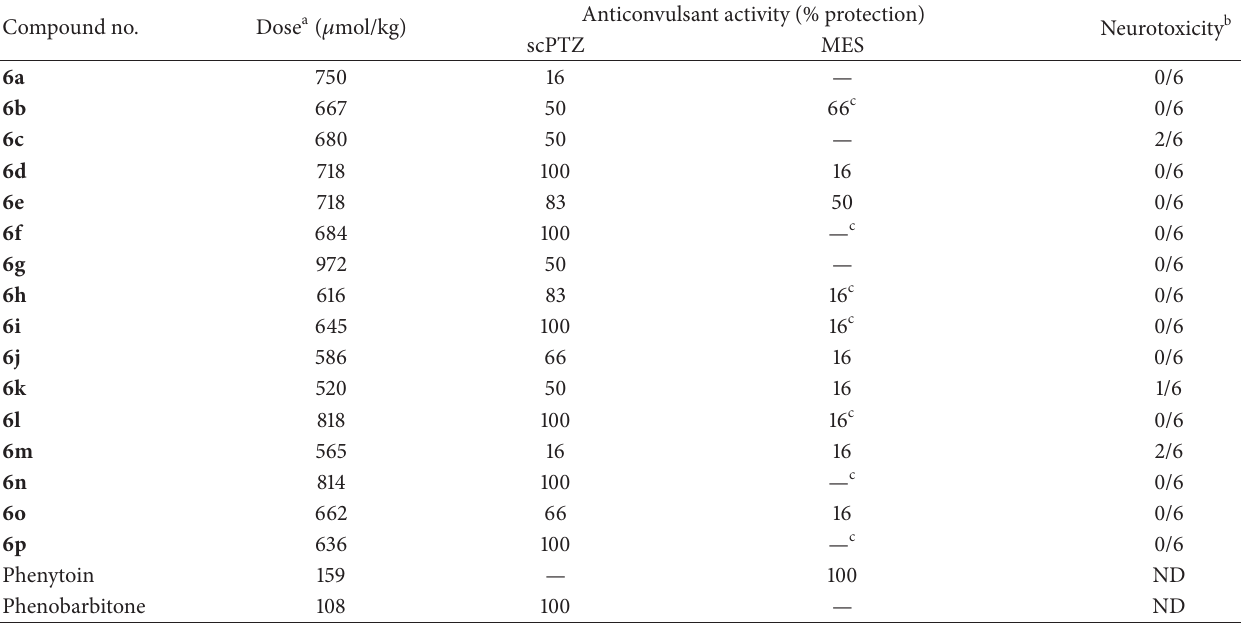
Table 1: Anticonvulsant potential and neurotoxicity of the target compounds 6a–p . Compound no.